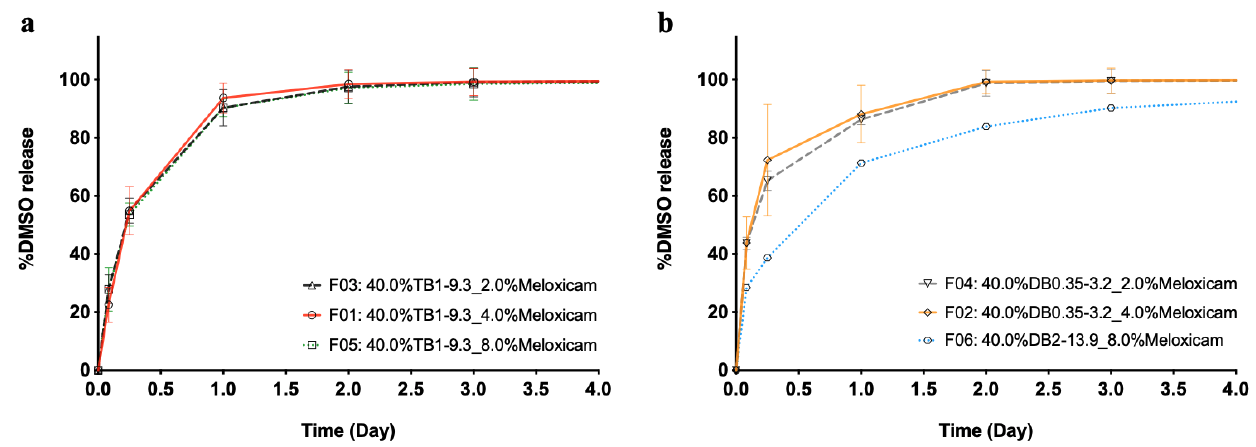
Figure 3. DMSO release from (m)PEG–PTMC triblock ( a ) and diblock ( b ) copolymer-based formulations with different API:copolymer ratios.